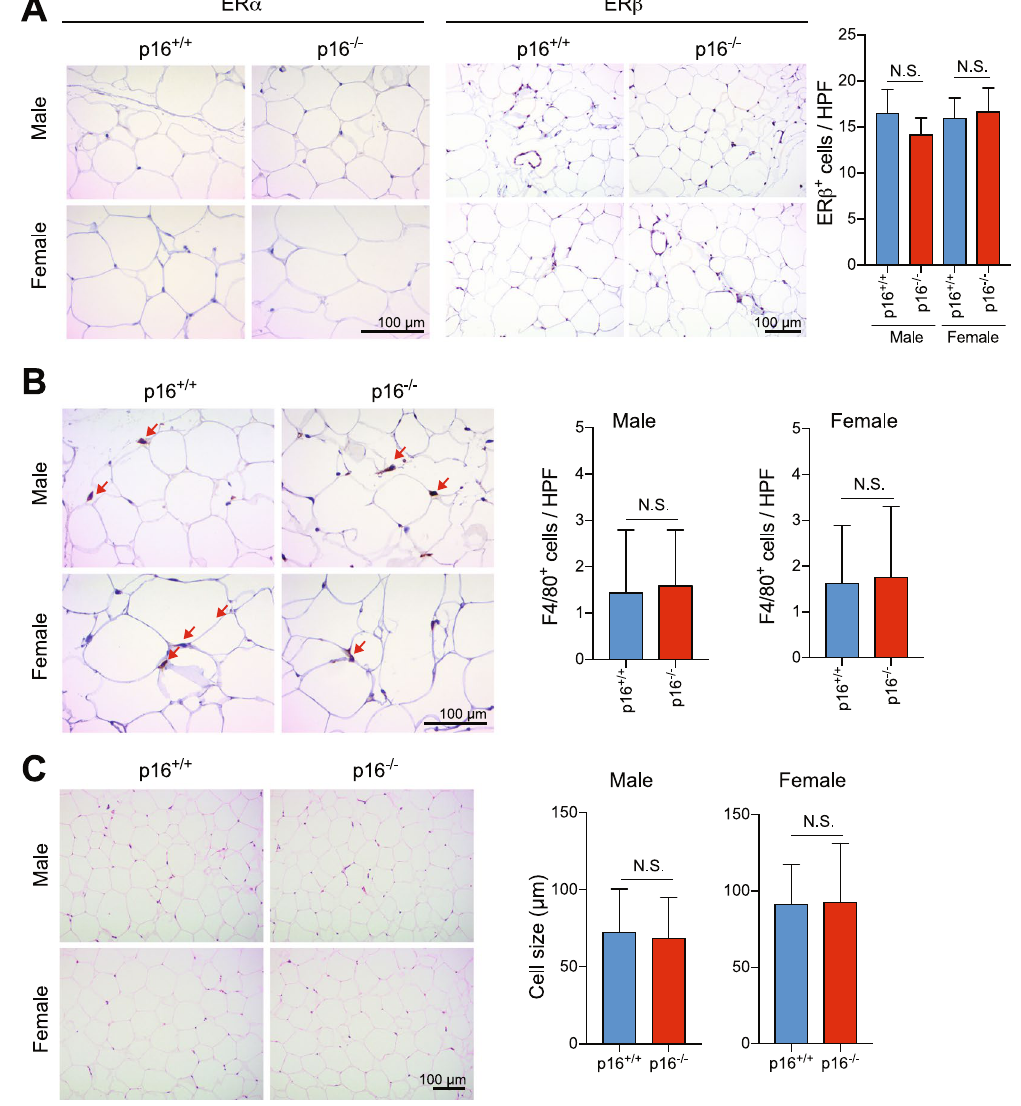
from p16 + / + and p16 − / − FVB male and female mice were stained with anti-ER α (left panel) and anti-ER β (right panel). ER β + cells (brown) were quantified at high power (n = 15). ( B ) Number of F4/80 + cells (brown) (n = 15). ( C ) Adipocyte size (n = 15). HPF, high power field. Results are mean ±